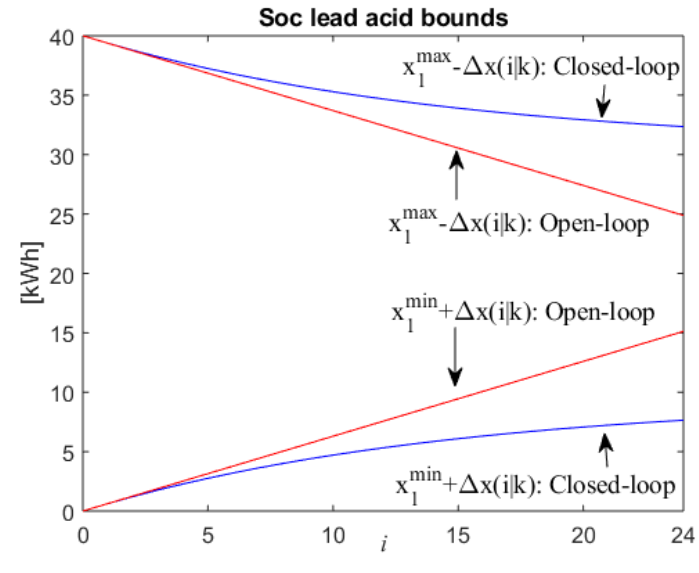
Figure 9. SOC bounds of leadacid